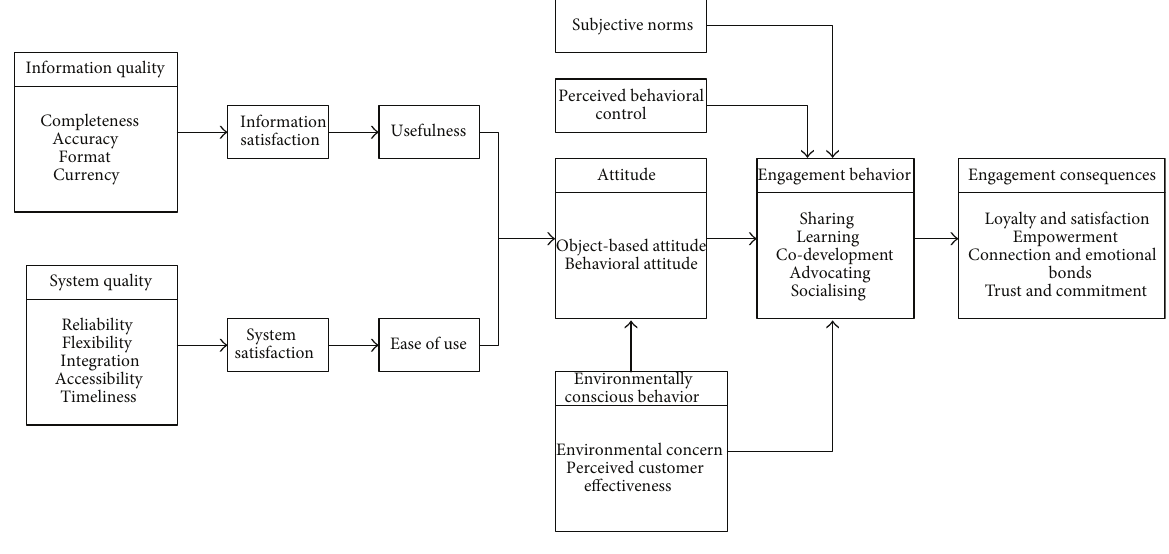
Figure 2: Research framework of this study.